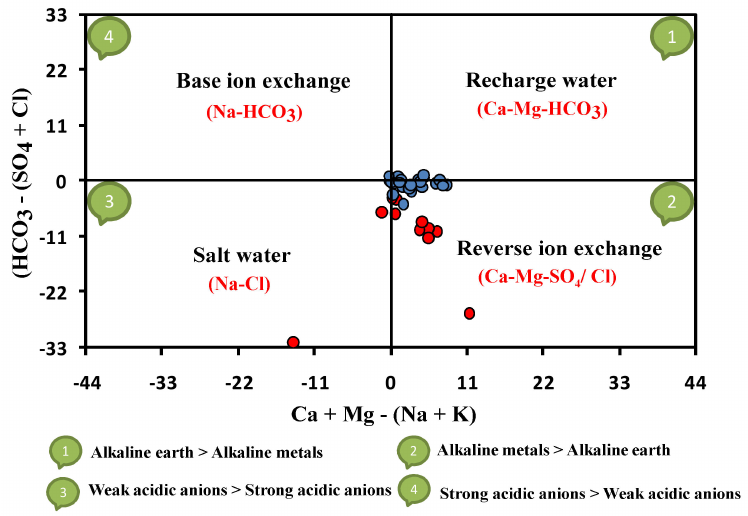
Figure 3. Hydrochemical facies of groundwater samples in the Western Desert and Central Nile Delta based on Chadha’s